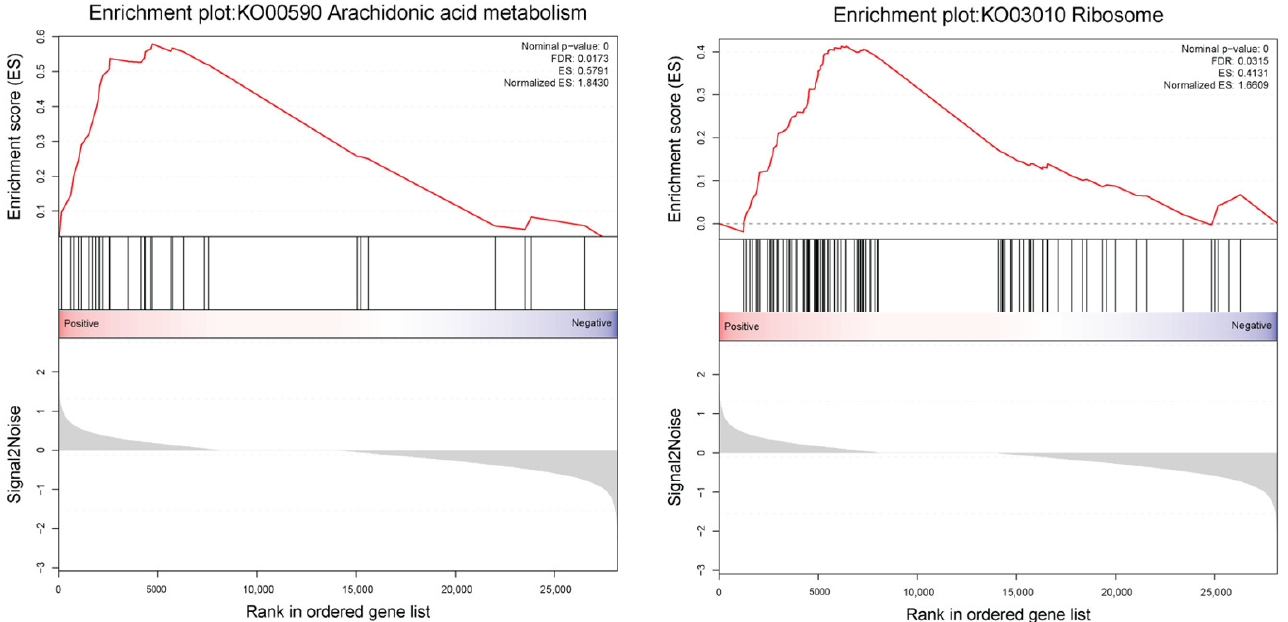
Figure 8. Enrichment plots from the gene set enrichment analysis of KEGG pathways in response to the 5-AzaC treatment of S. japonica (p -val. < 0.05 ) . ES indicates the enrich score, and NES indicates the normalized enrich score.